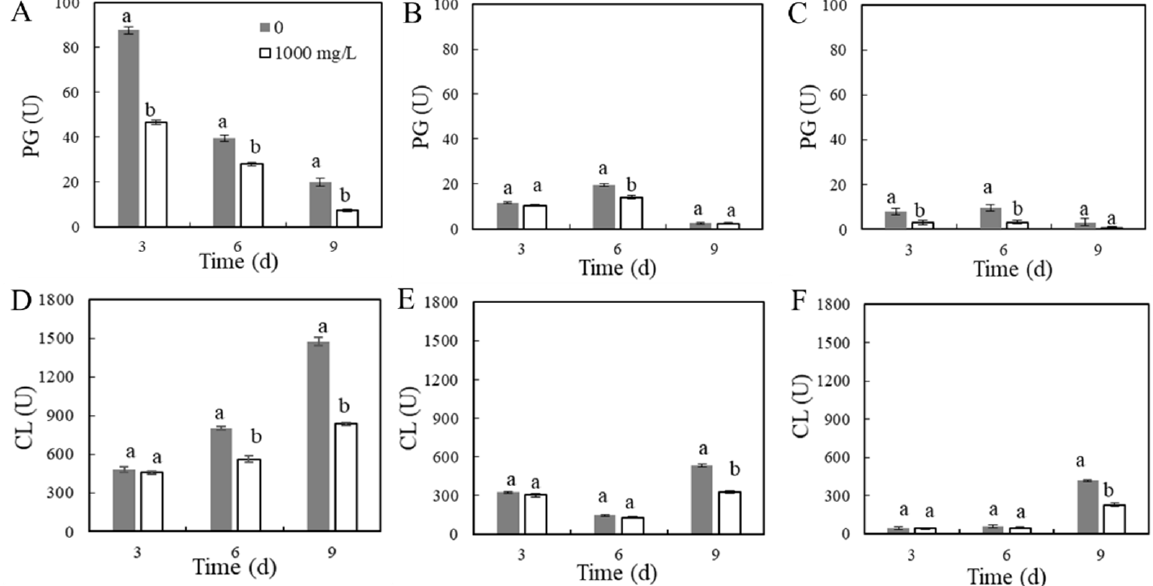
Figure 7. Effects of ε -PL treatment on cell-wall-degrading enzymes in different areas of the P. expansum –apple interaction. The activities of cell-wall-degrading enzymes were measured on days 3, 6, and 9 of apple storage. Determination of PG activity in area A ( A ), area B ( B ), and area C ( C ) of the apple at different times; determination of CL activity in area A ( D ), area B ( E ), and area C ( F ) of the apple at different times. The vertical bar represents the standard deviation (n = 3). Different letters indicate significant differences according to Tukey’s test ( p < 0.05).